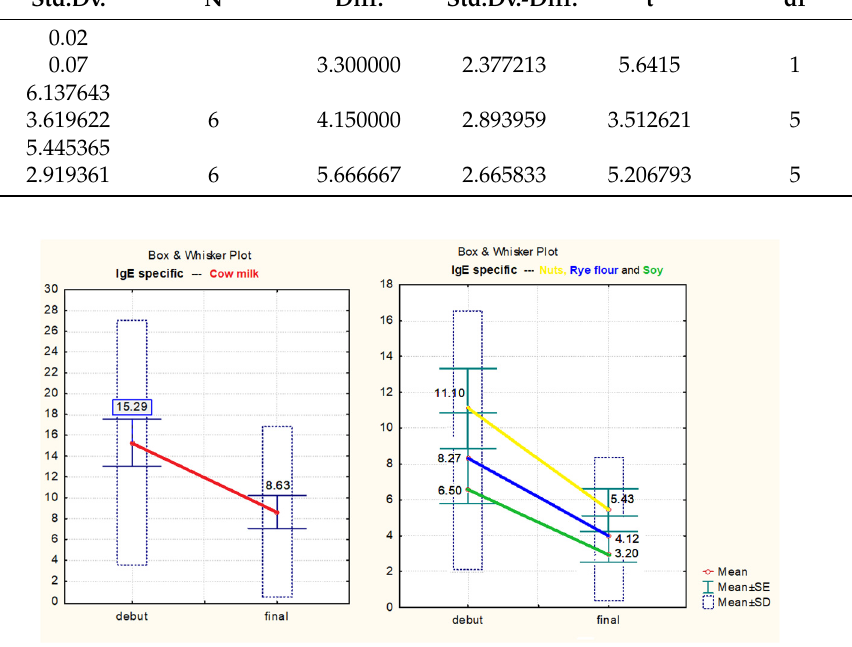
Figure 6. Specific IgE values in dynamics for strawberry, peanuts, and fish. The mean values in dynamics for specific IgE of rye flour, soy, and nuts are described in Table 7. Table 7. Comparison of average values in dynamics for specific IgE of rye flour, soy, and nuts. t -Test for Dependent Samples Mean Std.Dv.